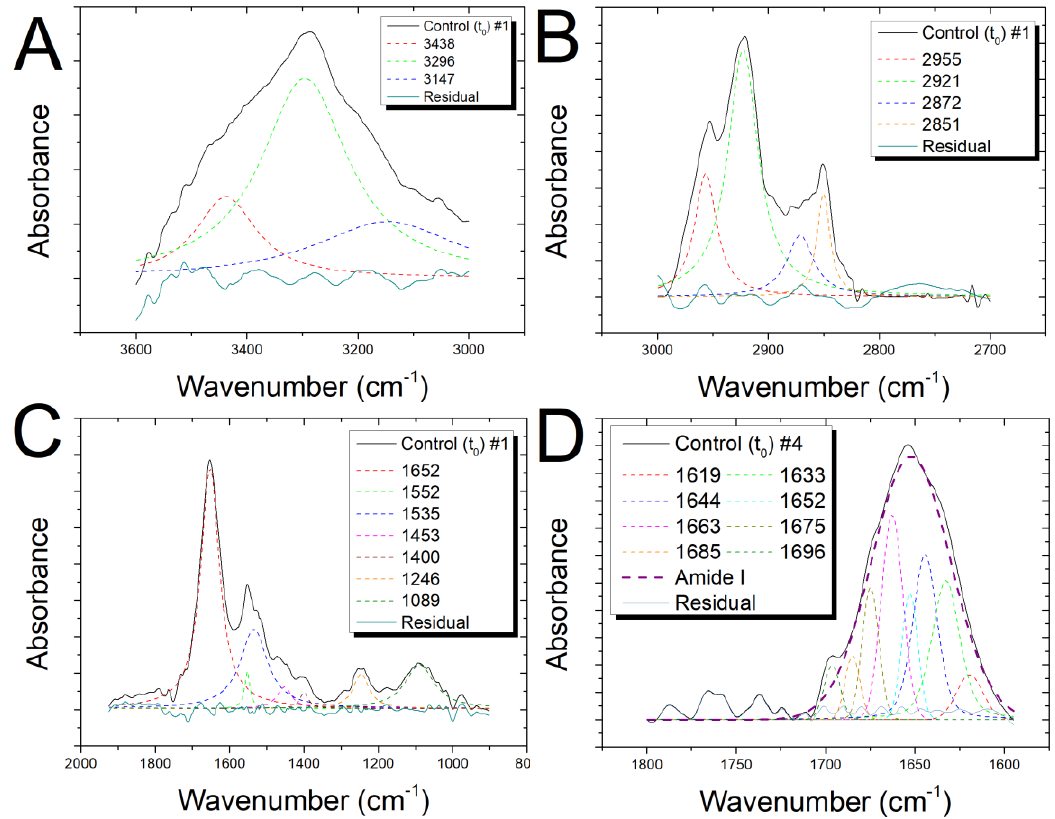
Figure 2. Spectra of one unexposed sample ( A ) in the range 3600–3000 cm − 1 , ( B ) 3000–2700 cm − 1 , ( C ) 2000–900 cm − 1 , and ( D ) 1800–1600 cm − 1 with the results of the deconvolution analysis of peaks using Lorentzian curves and fit residual.